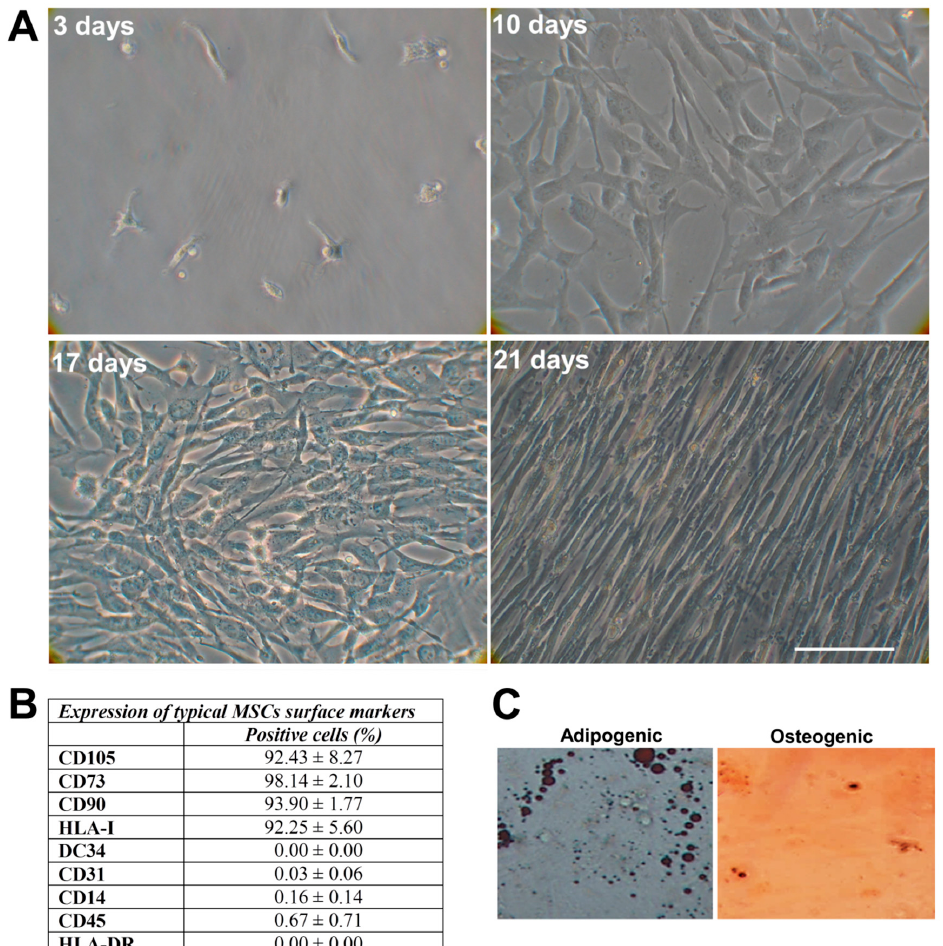
Figure 2. Characterization of mesenchymal stem cells derived from cord lining membrane (hCL-MSCs). ( A ) Morphology of cell outgrowth from the explants of hCL after 3, 10, 17, and 21 days (until P0) as visualized by phase-contrast microscopy (magnification 32×). hCL-MSCs adhere completely to plastic, exhibit fibroblastic morphology and show a radial or spiral growth (clearly visible at 17 days). Scale bar: 100 μ m. ( B ) Typical hCL-MSCs surface markers. Percentage mean ± standard deviation (S.D.) ( C ) Representative images of hCL-MSCs after being induced in adipogenic and osteogenic di ff erentiation (magnification 20 ×